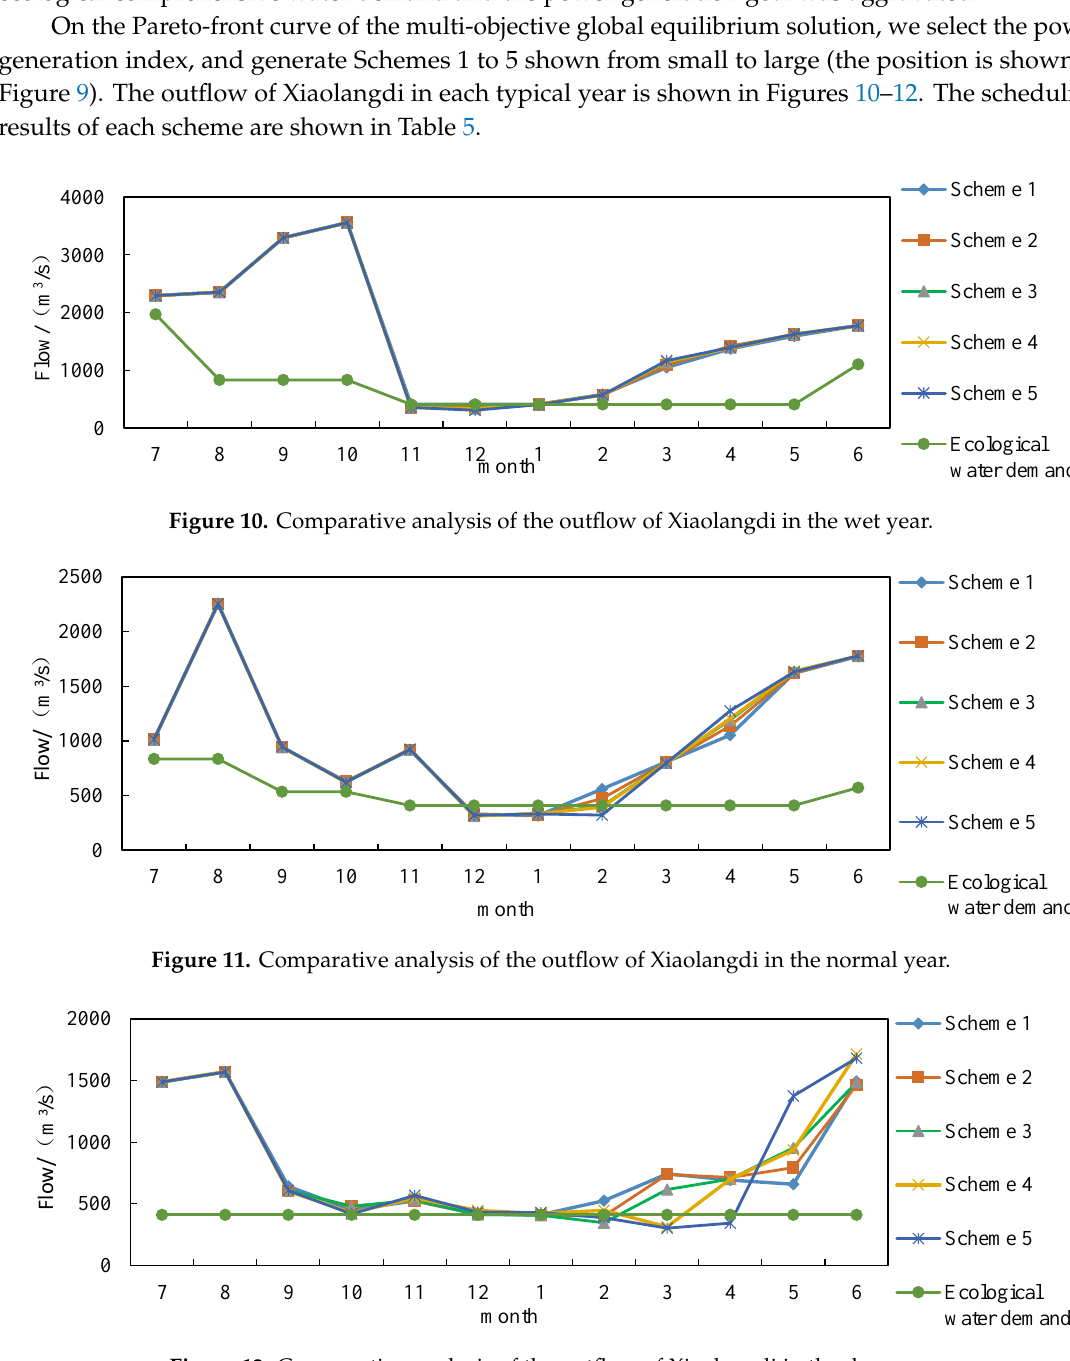
Figure 9. Multi-objective Pareto-front curves in each typical year.